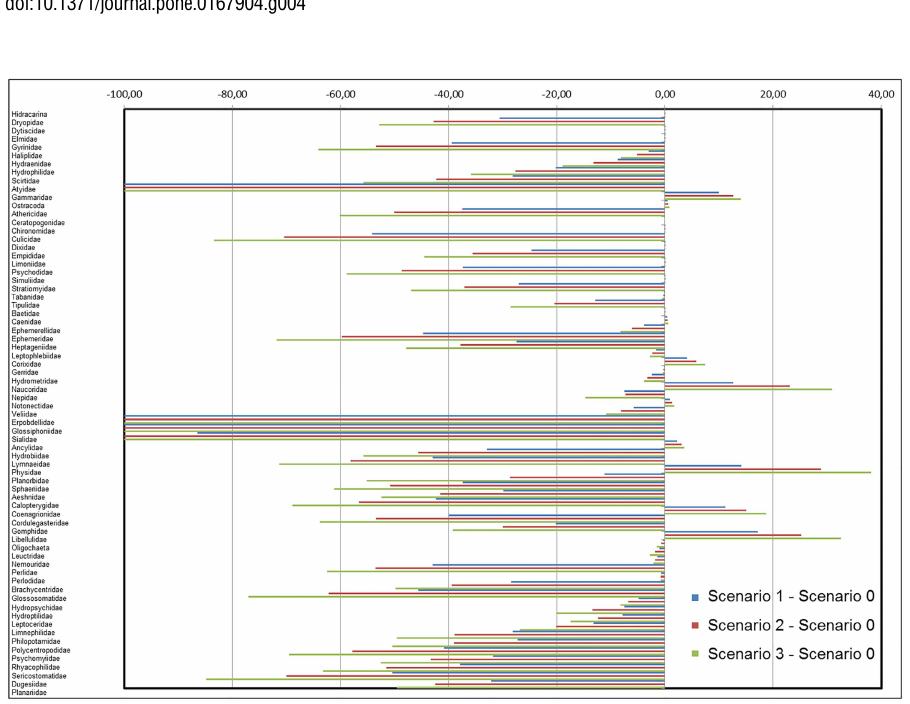
Fig 5. Percentage of shifts in area of presencefor each taxon. Differencein number of grids where taxa are present with probabilityof capture (cid:21) 50% betweeneach scenariomodelled: scenario 1 (+1.70˚C and -10% flow), scenario 2 (+2.45˚Cand -20% flow), and scenario3 (+3.30˚C and -30% flow), and scenario0 (current conditions)